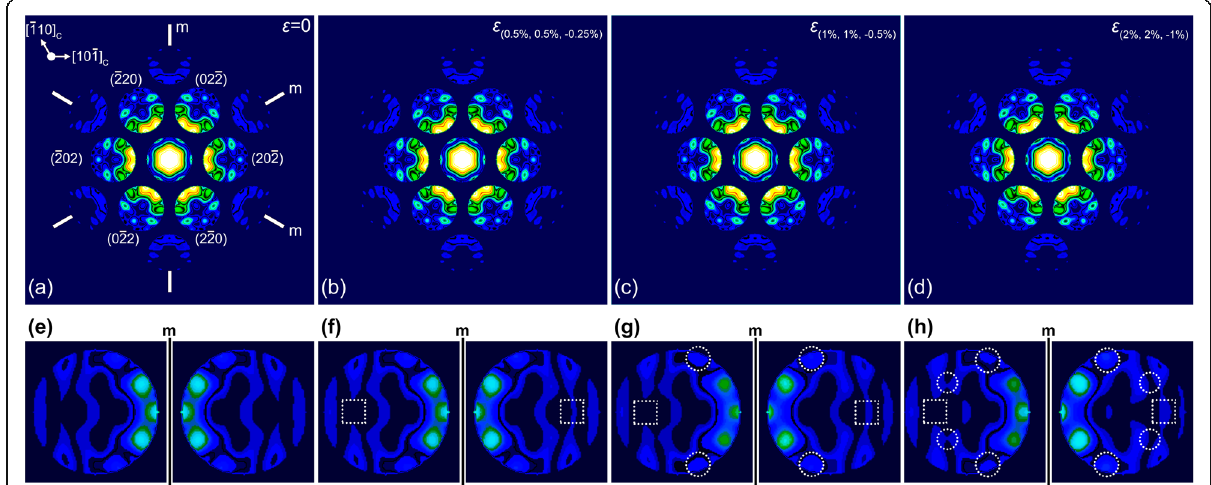
Fig. 3 Calculated CBED patterns for the perfect Si structure and ( b - d ) the strained Si structures at the zone axis of [111] C . The amount of strain is denoted in each simulated CBED